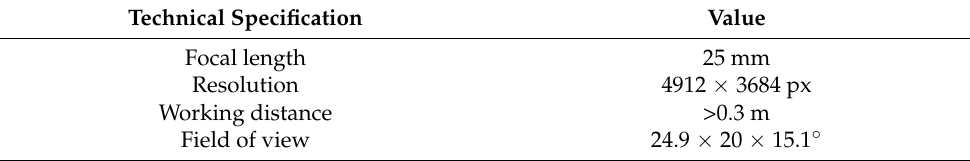
Table 2. Technical specifications of the camera.